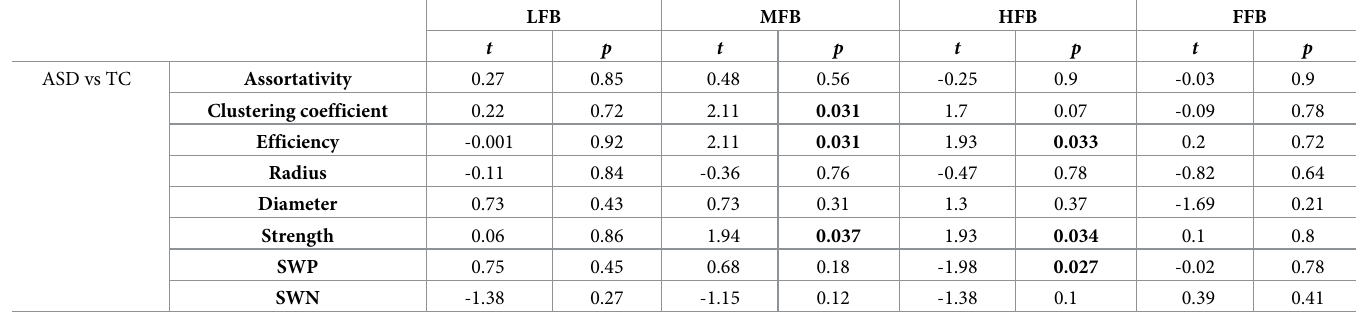
Table 2. Statistical comparison between ASDs and TCs for global metrics of the graph. The t and p are statistical and corrected probability values, respectively.